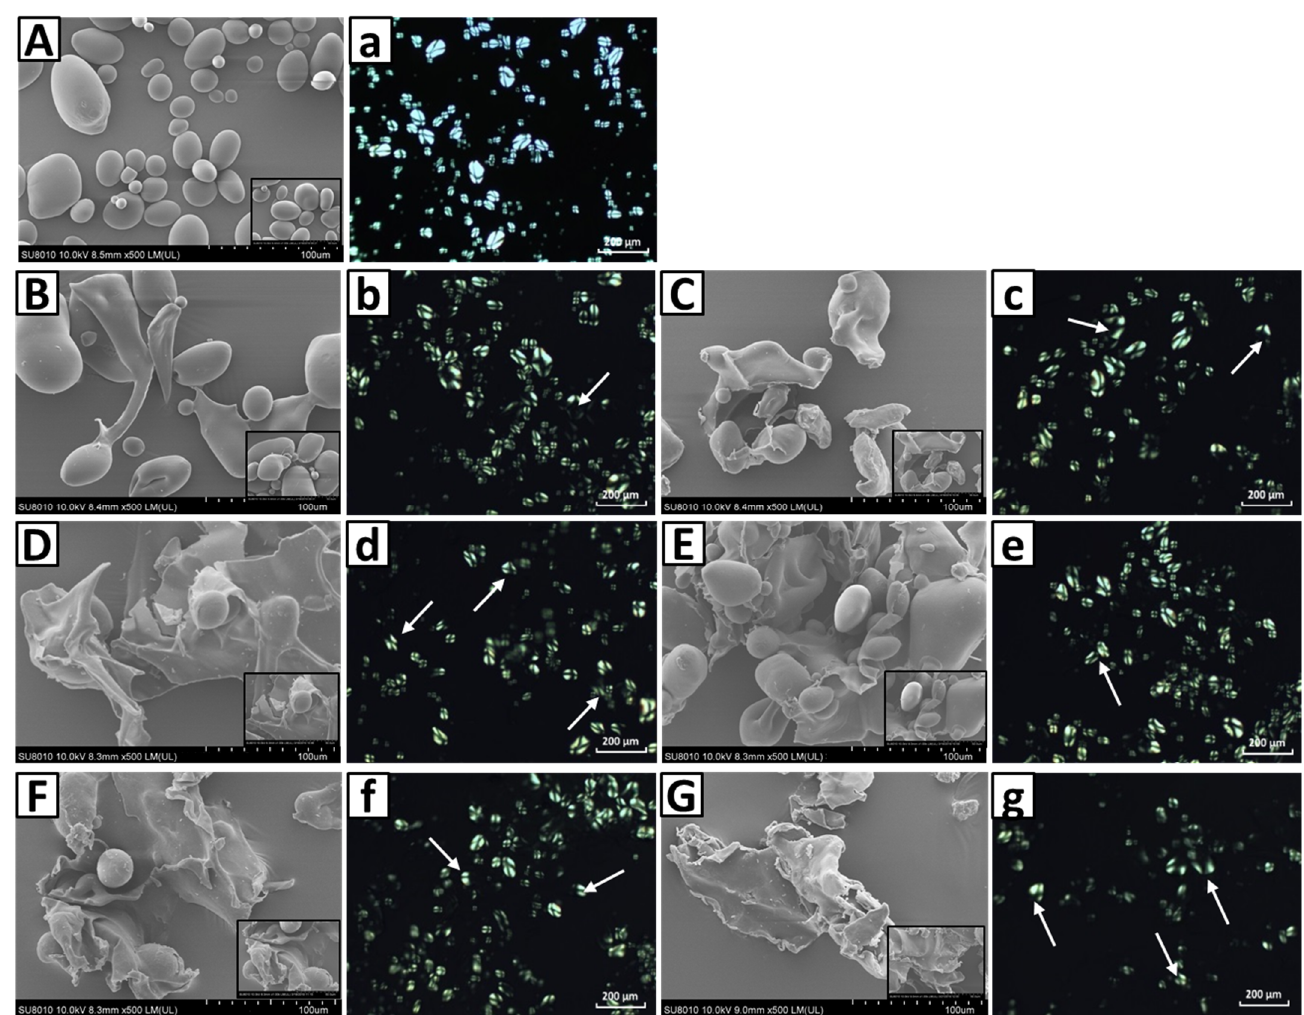
Figure 2. Scanning electron micrographs (upper case: A – G ) and polarized light micrographs (lower case: a – g ) of the native ( A and a ) and partially gelatinized potato starch granules ( B – G and b – g ) heated at 59 °C ( B – D and b – d ) and 60 °C ( E – G and e – g ) for different times (B, b, E, and e: 1 min; C, c, F, and f: 6 min; D, d, G, and g: 18 min).